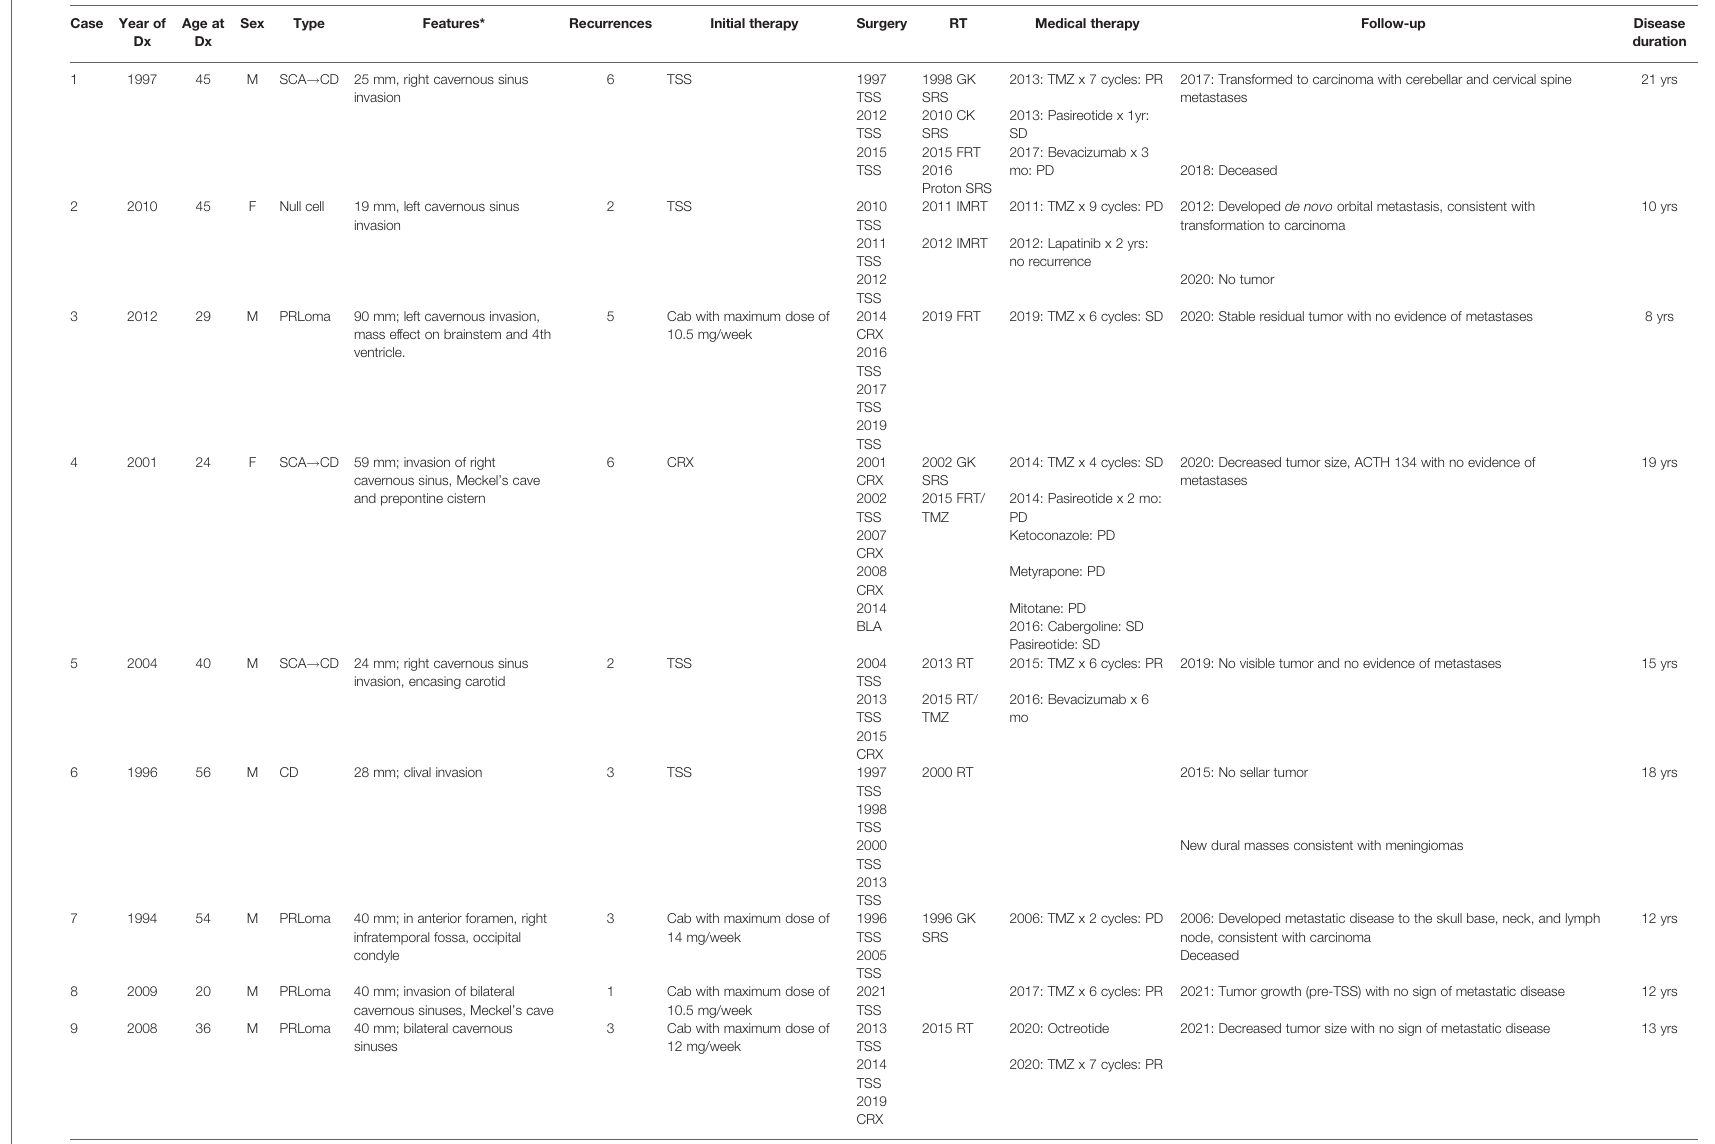
*Features of recurrent adenomas are listed if data were not available from initial presentation. ACTH,adrenocorticotropin;BLA,bilateraladrenalectomy; Cab,cabergoline; CD,Cushingdisease; CK,CyberKnife;CRX, craniotomy;Dx,diagnosis;FRT,fractionated radiationtherapy; GK,GammaKnife; IMRT,intensity-modulated radiation therapy; PD, progressive disease; PRL, prolactin; PRLoma, prolactinoma; PR, partial response; RT, radiation therapy; SCA, silent corticotroph adenoma; SD, stable disease; SRS, stereotactic radiosurgery; TMZ, temozolomide; TSS, transsphenoidal surgery; Yrs,